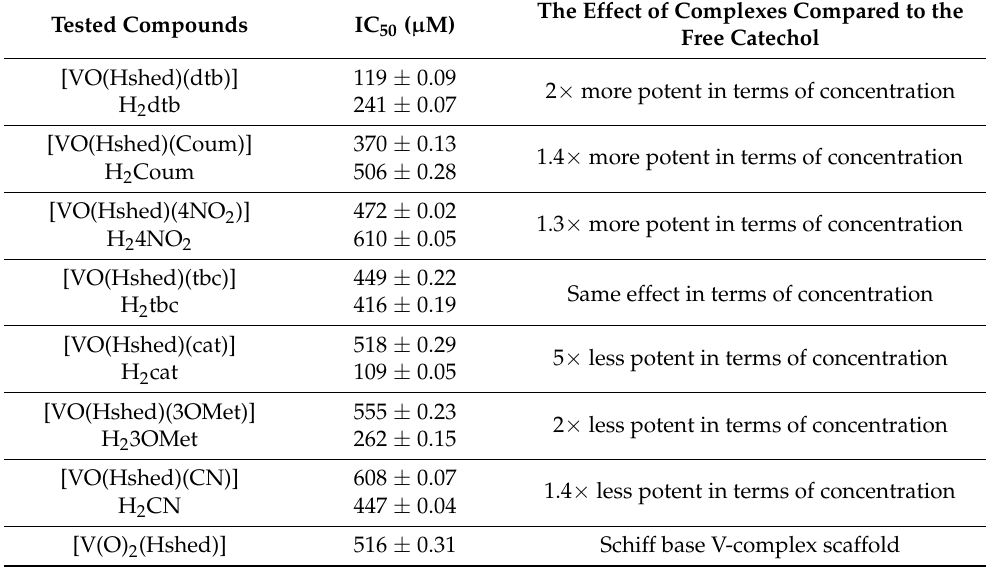
Table 2. Antibacterial activity (IC 50 ) of Schiff base vanadium complexes, the Schiff base [VO 2 Hshed] scaffold, and free catechols against M. smeg at 0.250